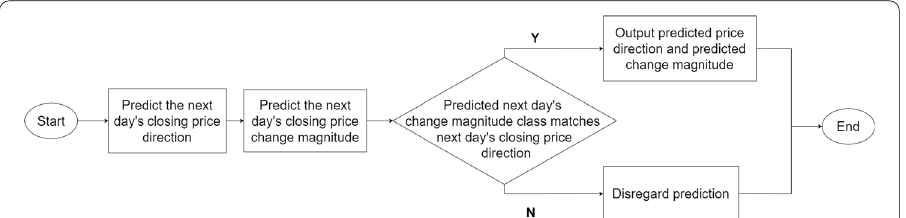
Fig. 7 Flowchart for voting